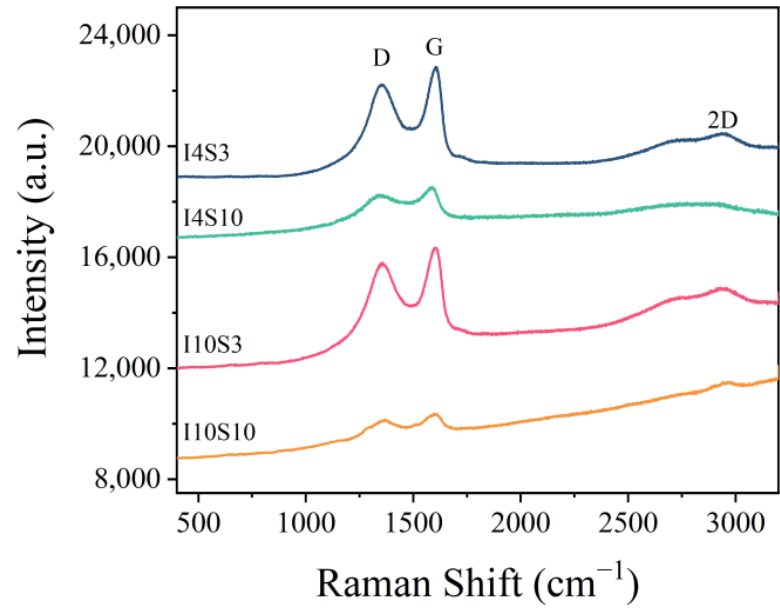
Figure 5. Raman spectra of specimens recycled from NaCl electrolyte.